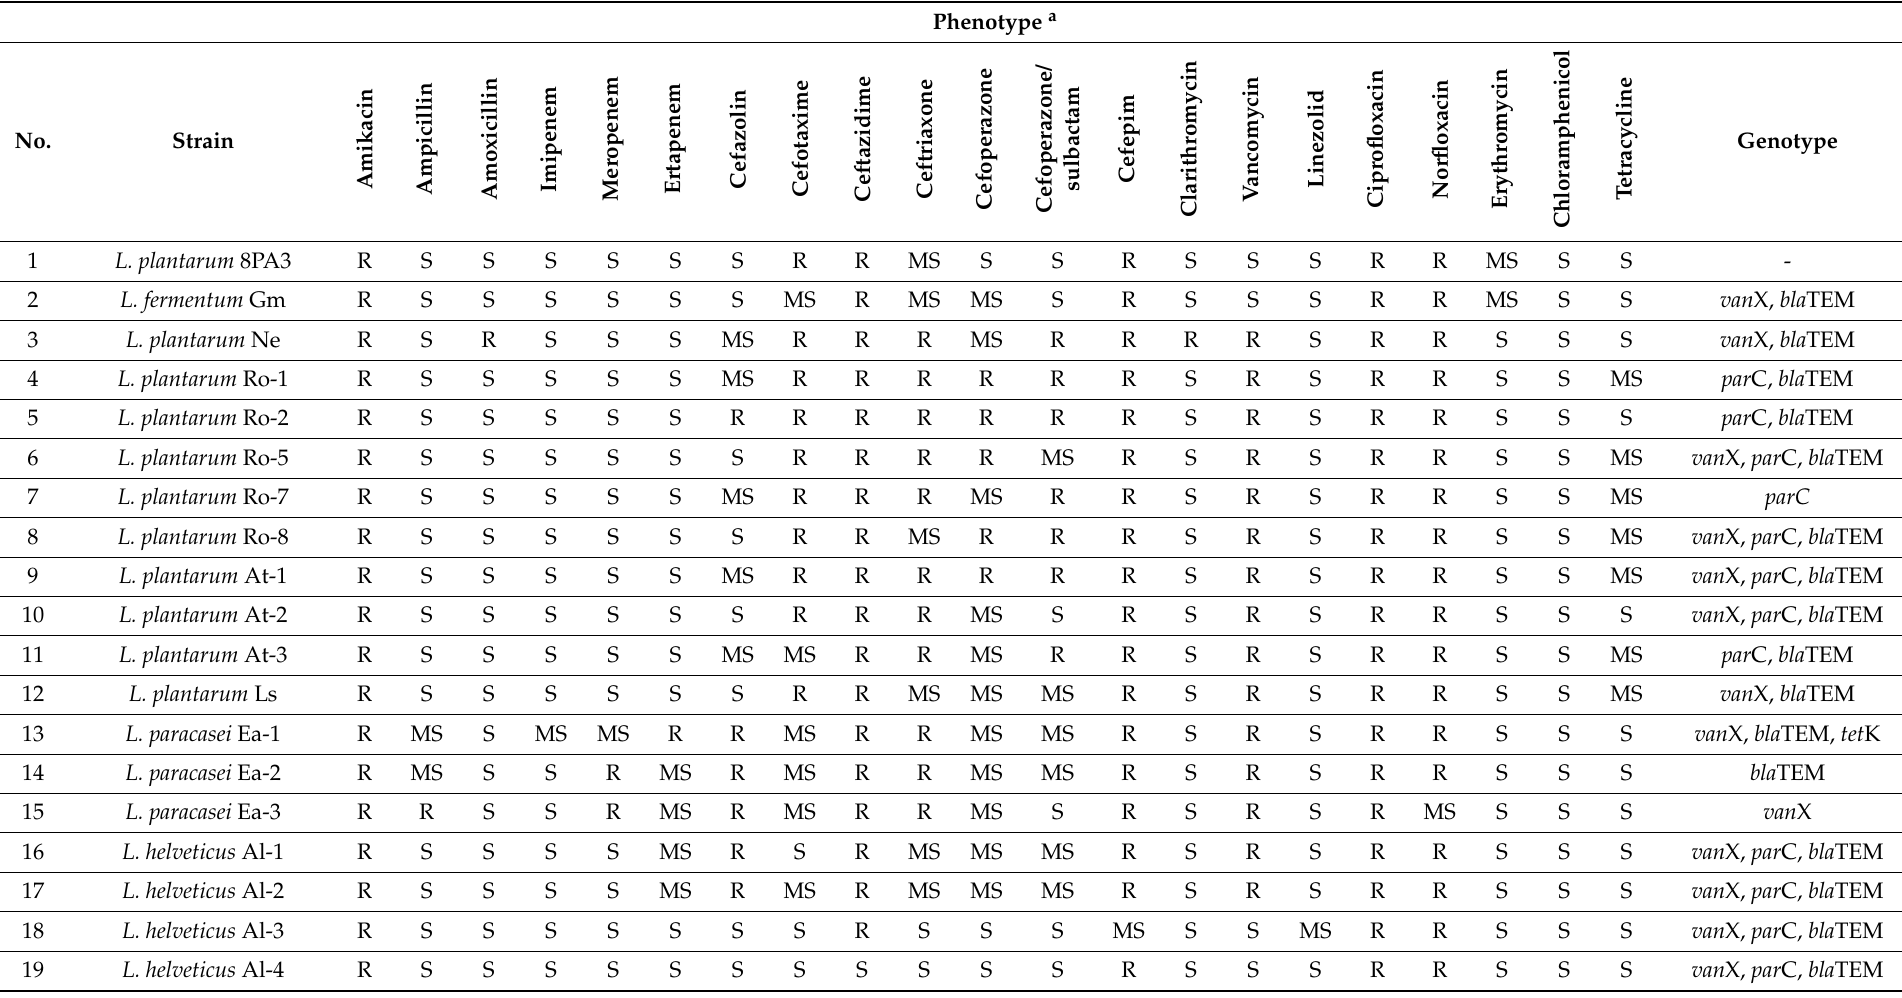
Table 2. Antibiotic resistance of Lactobacillus strains and detection of antibiotic resistance genes by polymerase chain reaction